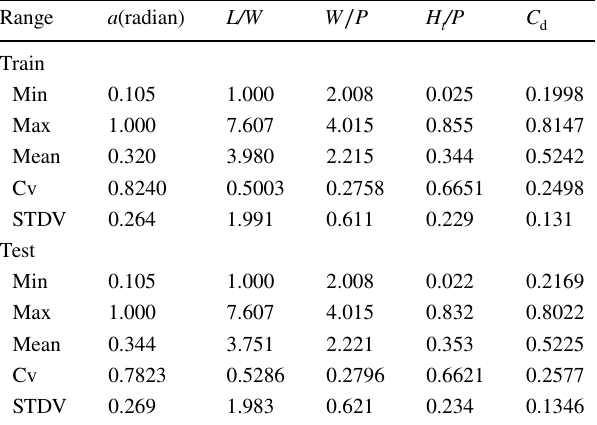
Table 1 Range of dataset used for training and testing of models Range